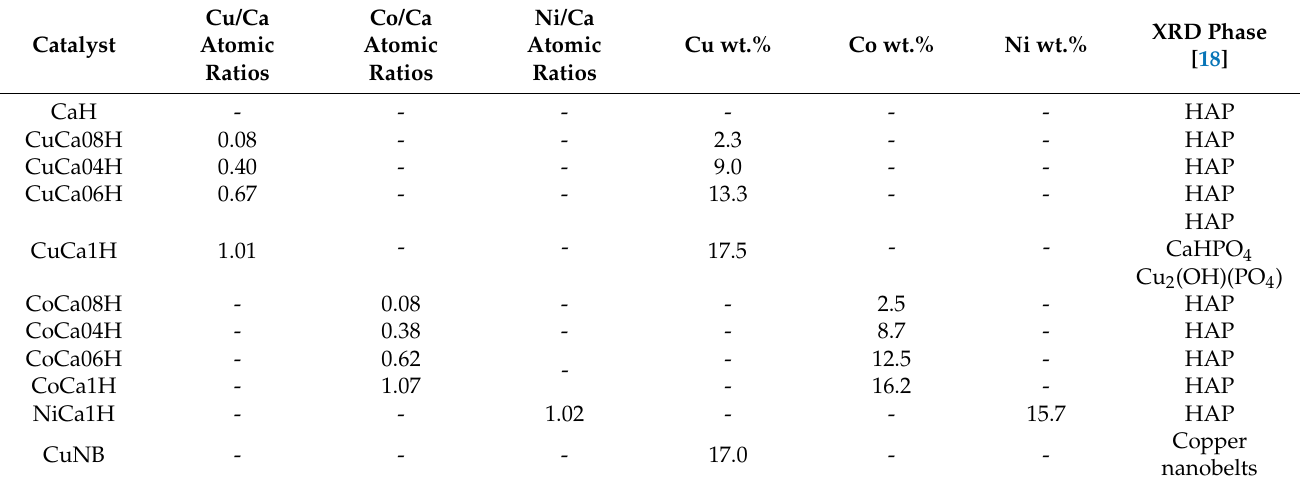
Table 4. Nomenclature and chemical compositions measured by ICP-OES analyses and XRD phases of the fresh solids